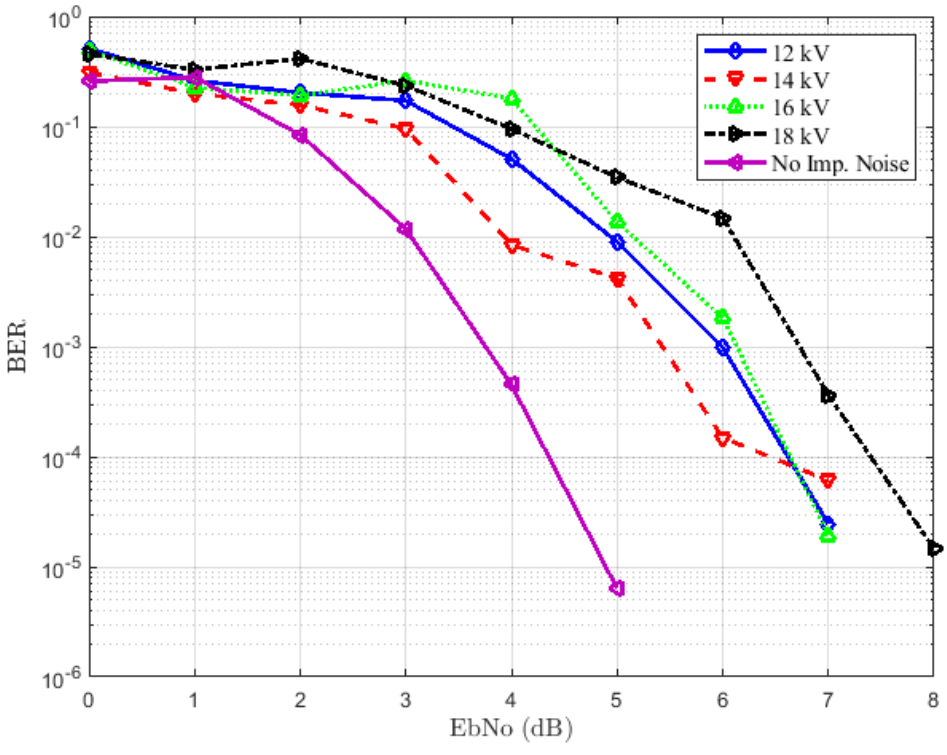
Figure 11. BER performance for different voltages in the NLOS